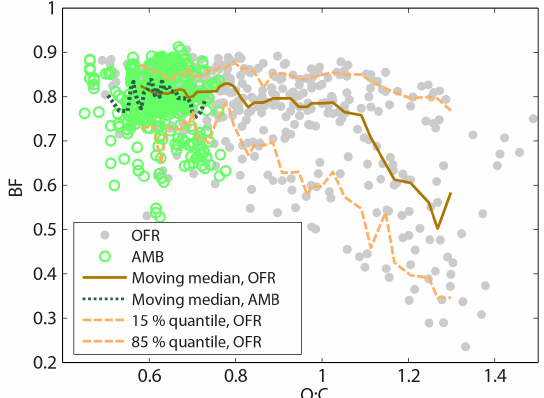
Figure 6. Bounced fraction (BF; 10min averages) of the ambient OA (green hollow dots) and corresponding OFR-treated OA (grey dots) vs. degree of oxidation (O:C). RH range of the ABI is limited to RH = 48 ± 4% and only data points where f OA ≥ 0 . 6 after the OFR treatment has used in the analysis. This has done to minimize the effect of RH and inorganics on BF in the figure. Moving median for ambient data (dark green dashed line) and for OFR data (brown line) are added to the figure as well as quantiles of OFR data (light brown dashed